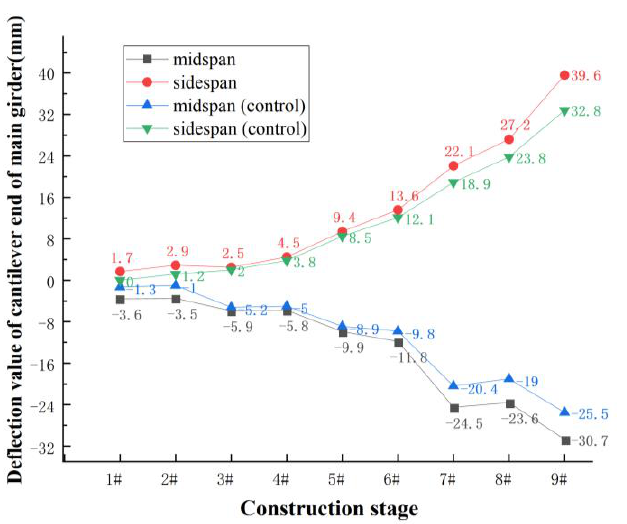
Figure 12. Beam cantilever tip deflection.